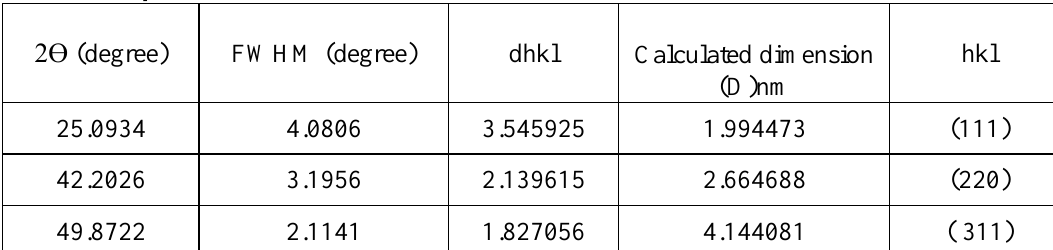
Table 1: The grain size of the CdSe/CdS core-shell nanoparticles, which obtained from Scherrer equation at diffraction scattering angle, Miler indices and FWHM of the diffraction peak.